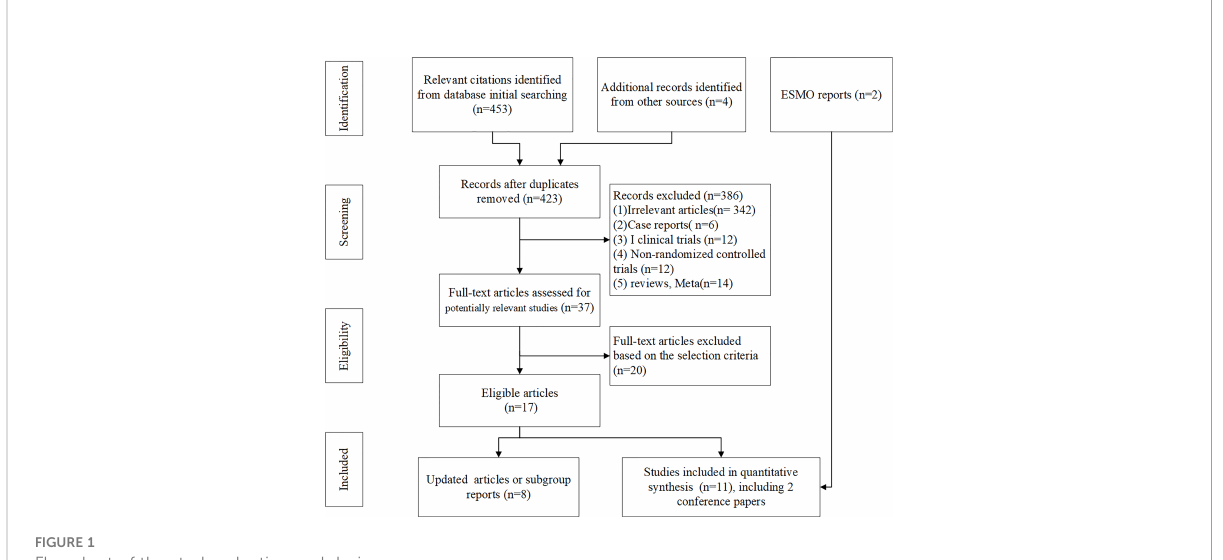
FIGURE 1 Flowchart of the study selection and